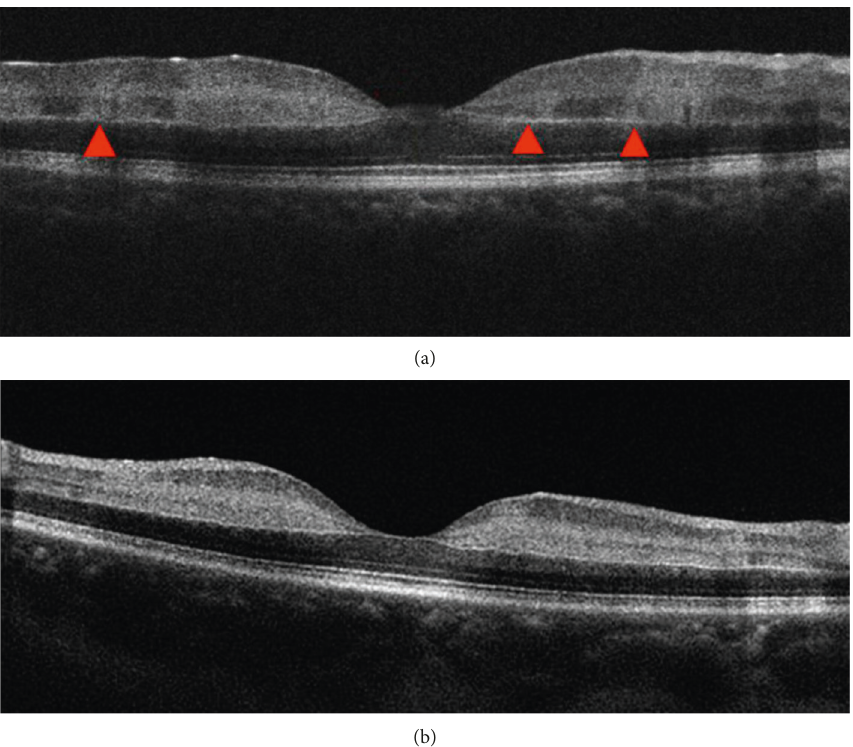
Figure 1: Paracentral acute middle maculopathy (PAMM) manifestation by optical coherence tomography (OCT) examination. (a) Mild edema between the retinal layers, with multiple side-by-side strong reflection bands in the inner nuclear retinal layer (INL) near the center of the macula, extending upward to involve the ganglion cell layer (red triangle). (b) Both INL and inner plexiform layer (IPL) reflections are